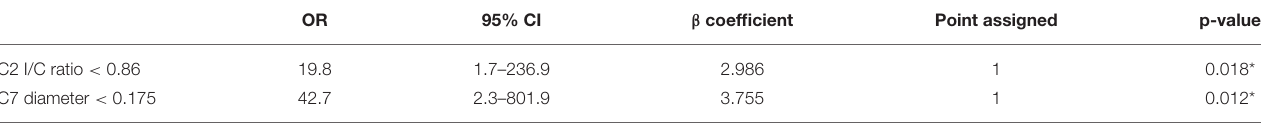
TABLE 4 | ICAO score and success rate of recanalization surgery. OR 95% CI β coefficient Point assigned p-value C2 I/C ratio <